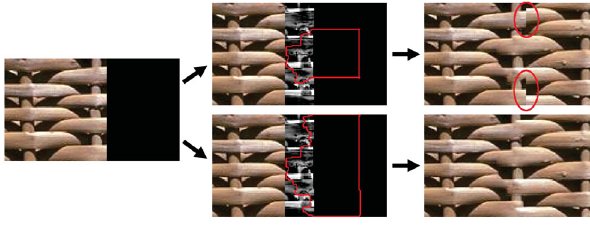
Fig. 8 Border flags controlling the extent of the region considered by visual matching during patch placement. Left: initial coverage with undefined regions on the right. Middle: error image in overlap region (grayscale) and two possible candidates for the boundary cut assigned the same cost in the yet empty areas of the canvas. The upper candidate does not consider the neighboring regions above and below the existing patch, while the lower candidate is aware of the unset regions. Right: difference in results.